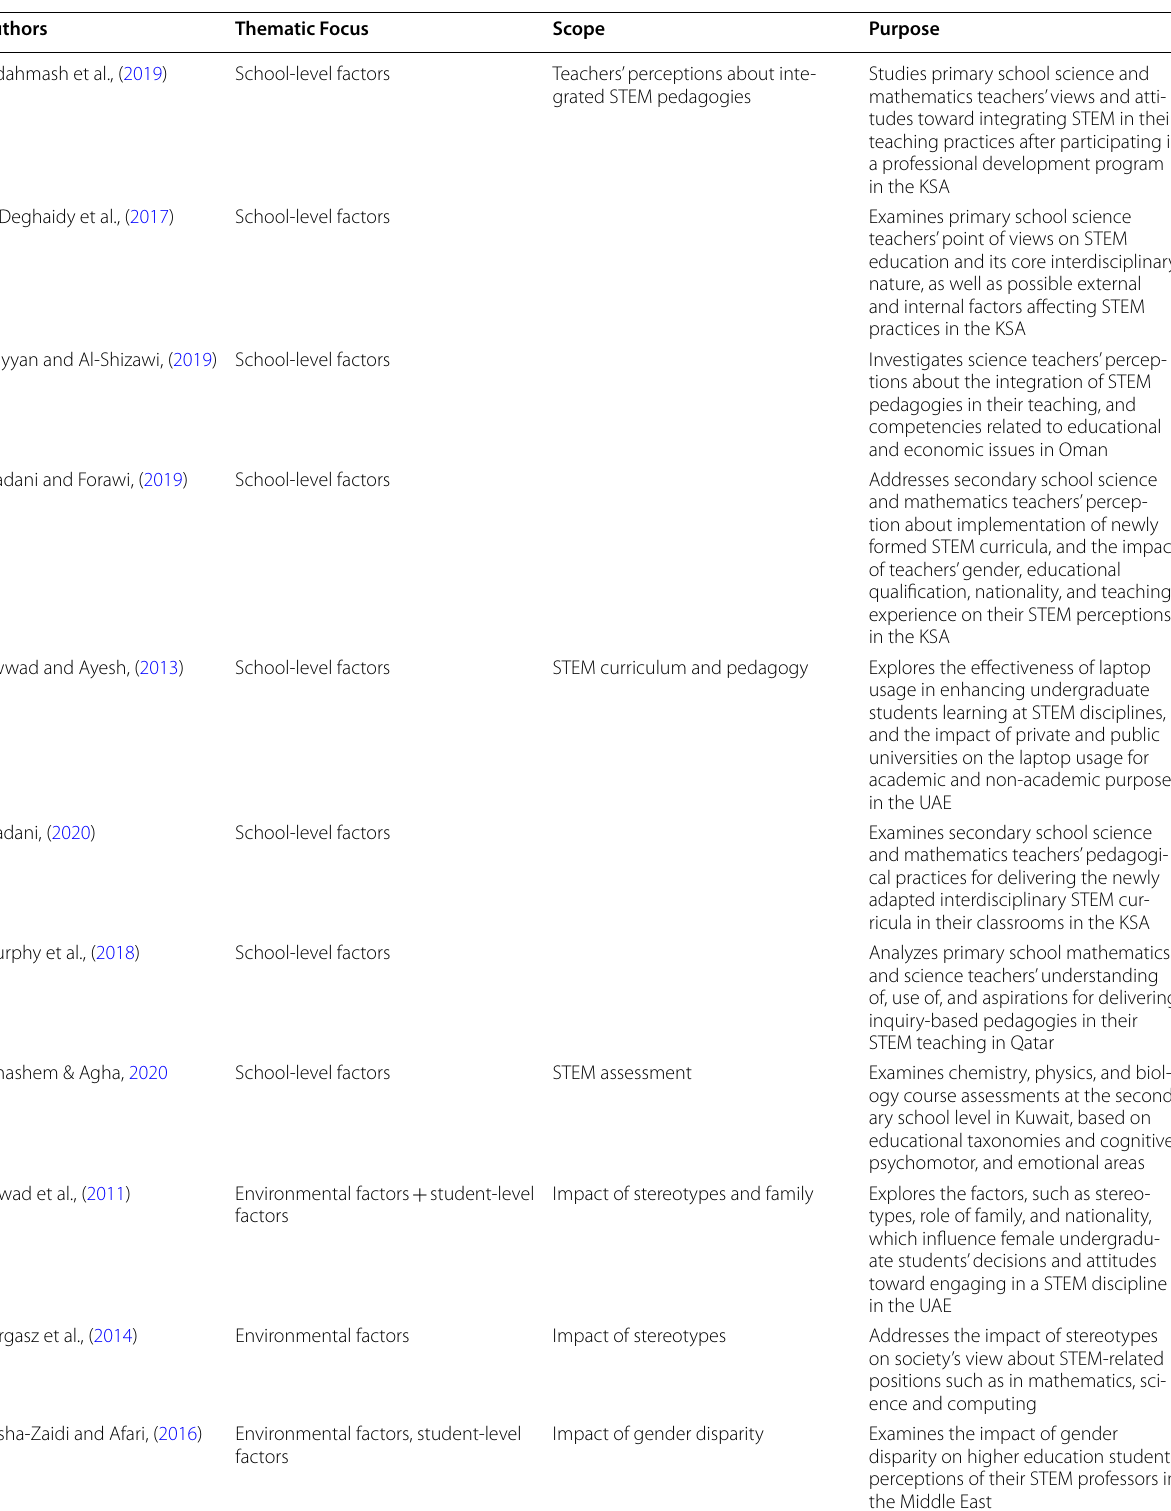
Table 3 Detailed analysis of thematic focus across the STEM